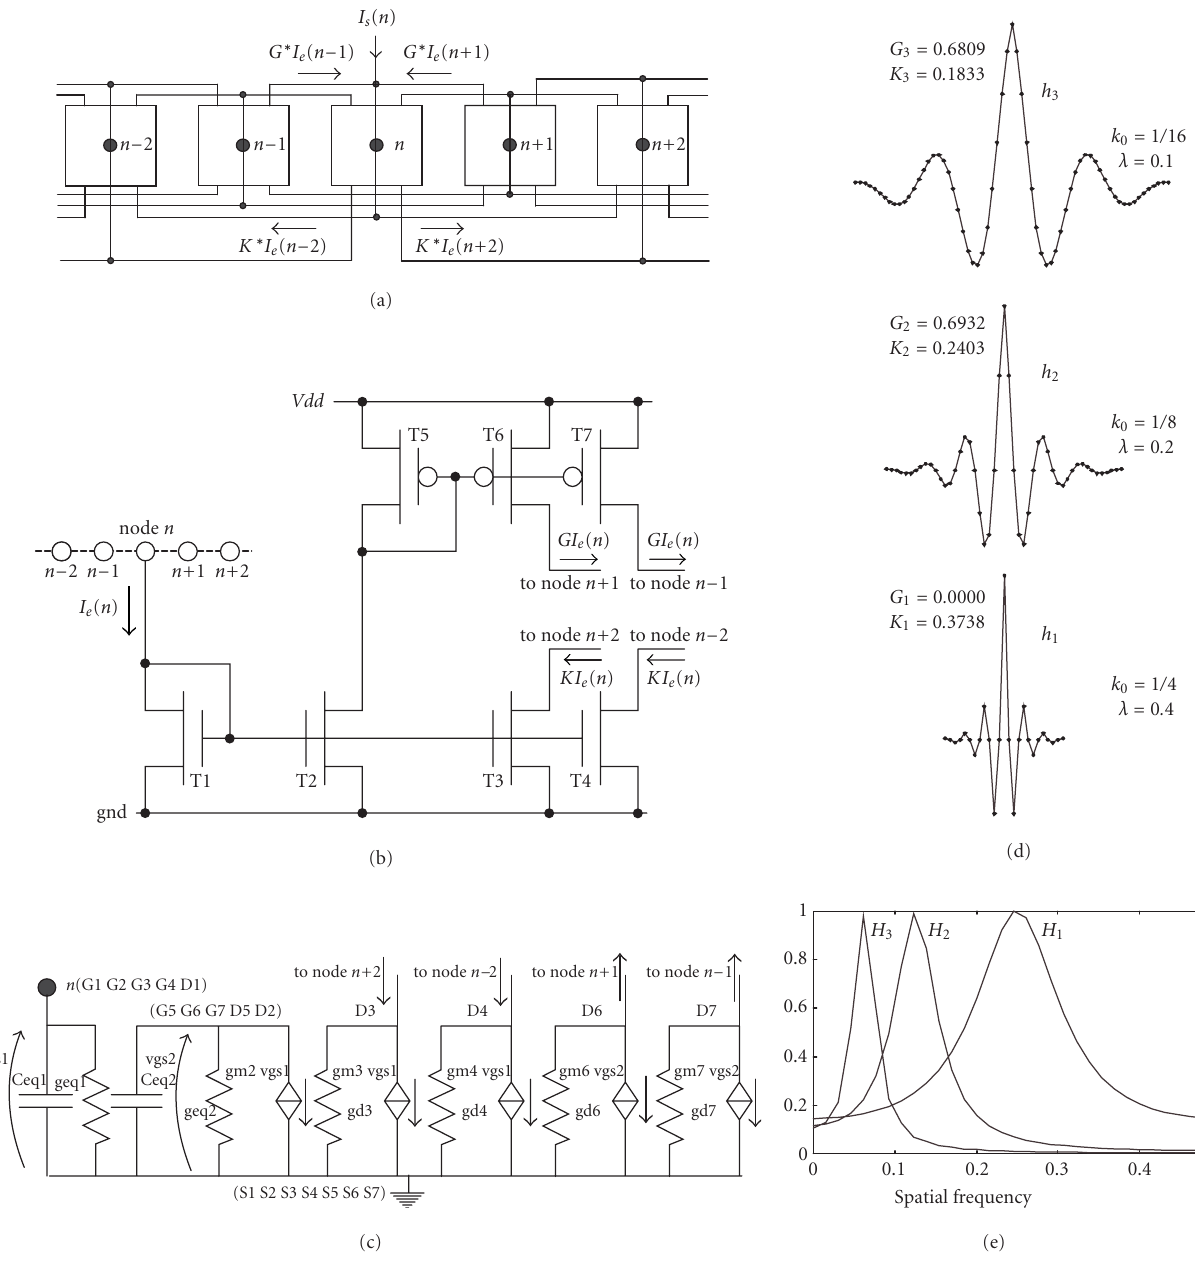
Figure 4: Spatial filtering. (a) Second-order lattice network represented as an array of cells interacting through currents. (b) Transistor-level representation of a single computational cell; (c) its small-signal circuital representation. (d–e) Spatial and spatial-frequency plots of the three Gabor-like filters considered; the filters have been chosen to have in the frequency-domain constant octave